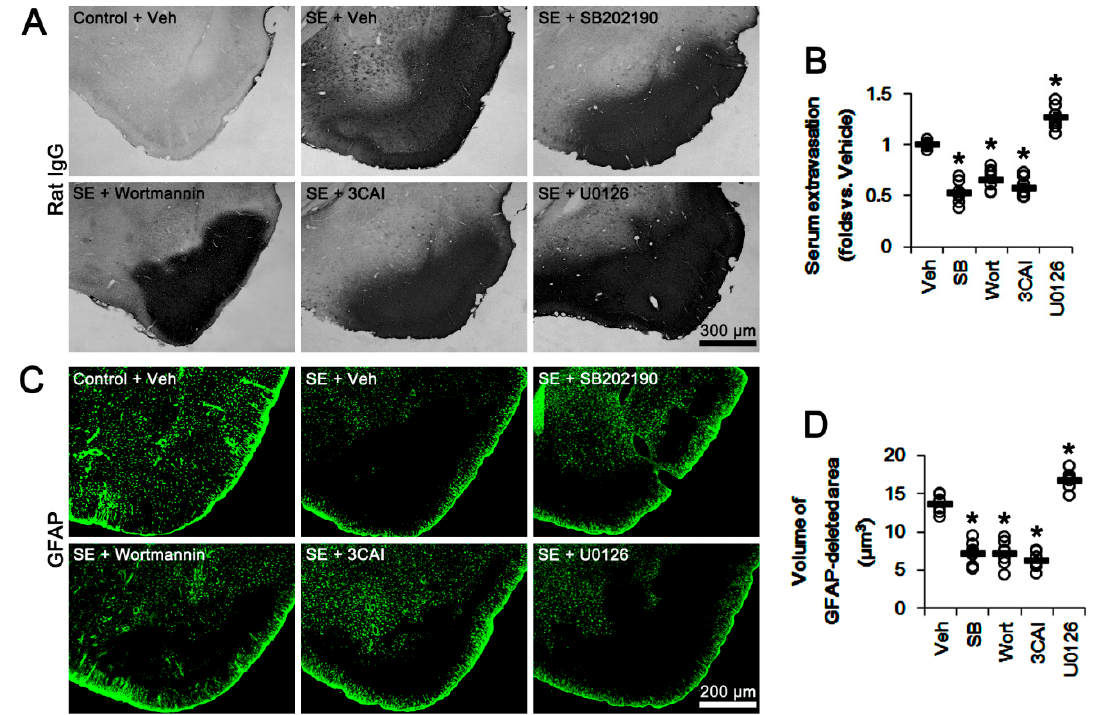
Figure 8. E ff ects of kinase inhibitors on vasogenic edema and astroglial degeneration in the PC following SE. SE evokes severe vasogenic edema and massive astroglial loss in the PC. As compared to vehicle, SB202190, wortmannin, and 3CAI attenuate serum extravasation and astroglial degeneration. However, U0126 deteriorates them. ( A ) Representative photographs for serum extravasation in the PC following SE. ( B ) Quantitative values (mean ± S.E.M) of serum extravasation following SE ( n = 7, respectively). Open circles indicate each individual value. Horizontal bars indicate the mean value. Error bars indicate S.E.M. Significant di ff erences are * p < 0.05 vs. vehicle (one-way ANOVA). ( C ) Representative photographs of astroglial loss in the PC induced by SE. ( D ) Quantitative values (mean ± S.E.M) of the volume of GFAP-deleted area following SE ( n = 7, respectively). Open circles indicate each individual value. Horizontal bars indicate the mean value. Error bars indicate S.E.M. Significant di ff erences are * p < 0.05 vs. vehicle (one-way ANOVA).